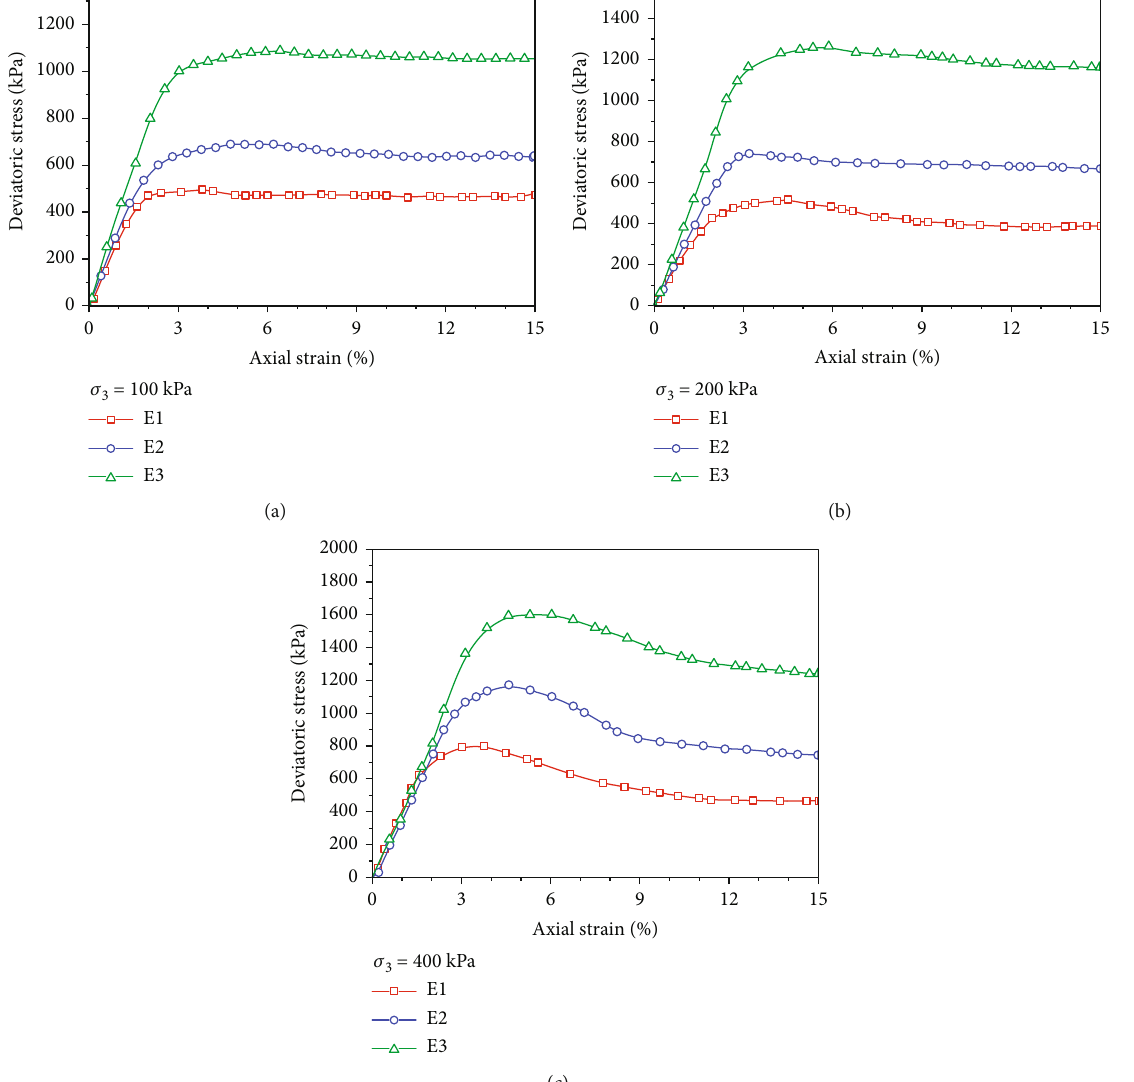
Figure 5: Deviatoric stress-strain curves of the samples E1-E3 under di ff erent con fi ning pressures: (a) σ = 400 kPa σ 3